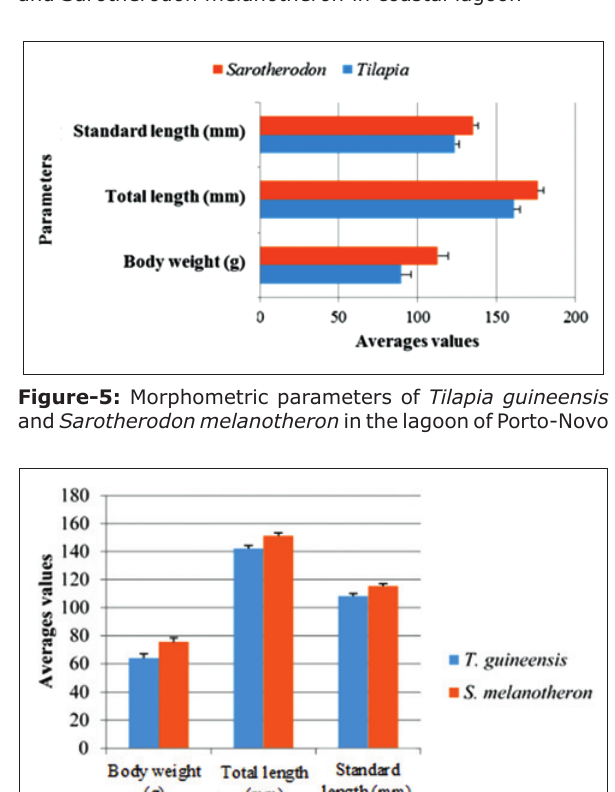
Figure-4: Morphometric parameters of Tilapia guineensis and Sarotherodon melanotheron in coastal lagoon